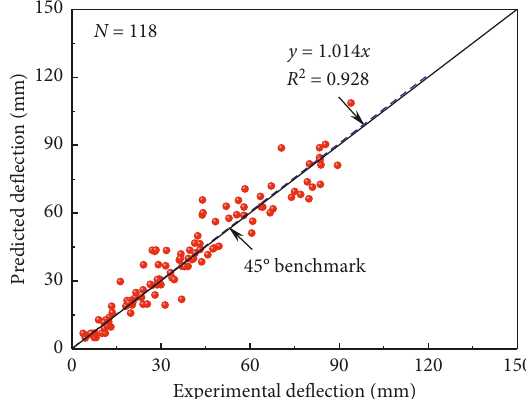
Figure 15: Comparison of experimental and predicted values of the maximum